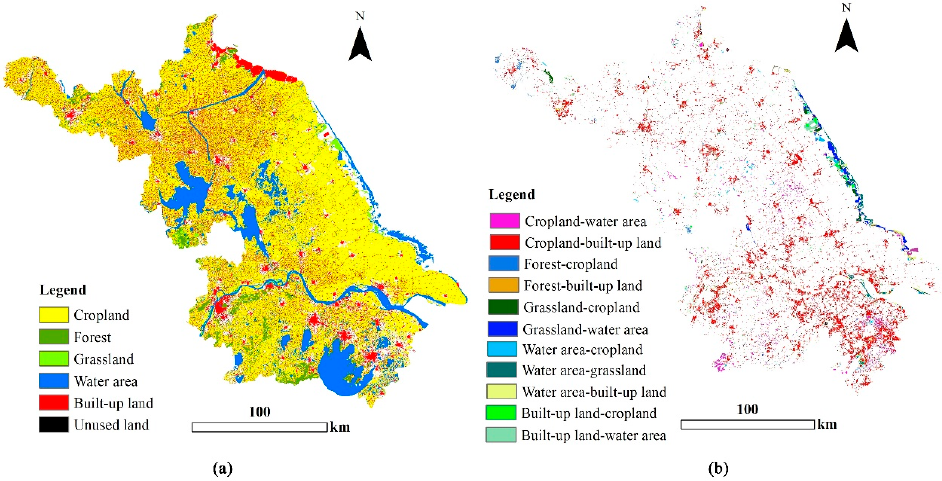
Figure 3. Spatial distribution of land with no change ( a ) and transfer change ( b